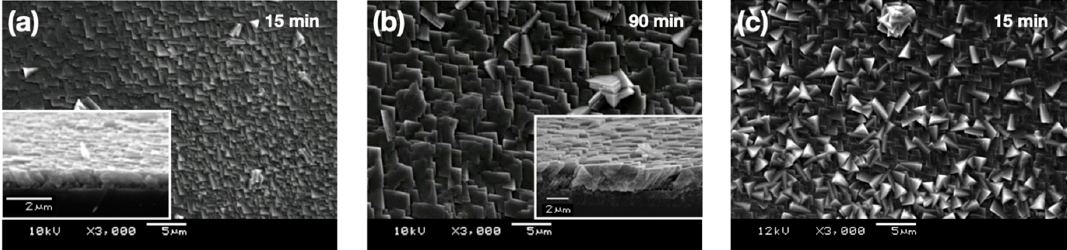
Figure 2. SEM images of the coating layers formed via ACC on single crystals of calcite (top down view) after 15 min ( a ) and 90 min ( b ); cross-sections of the coating layers after fracture were shown as inset images. A SEM image of the coating layer formed without ACC stabilization ( c ): top down view after 15 min.